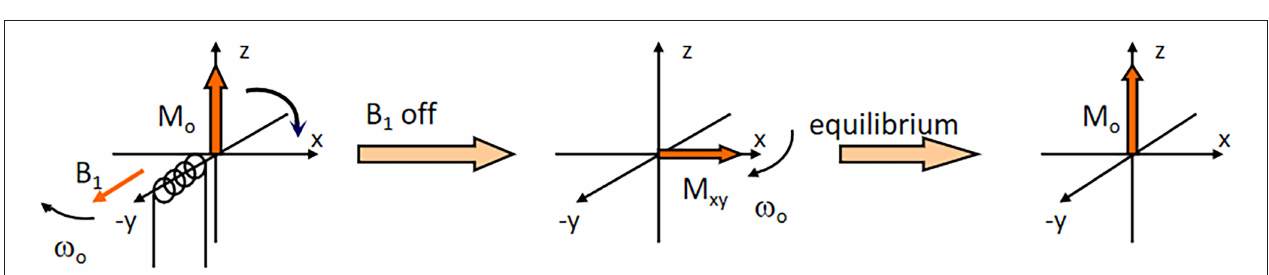
FIGURE 2 | Schematic illustration of the relaxation time